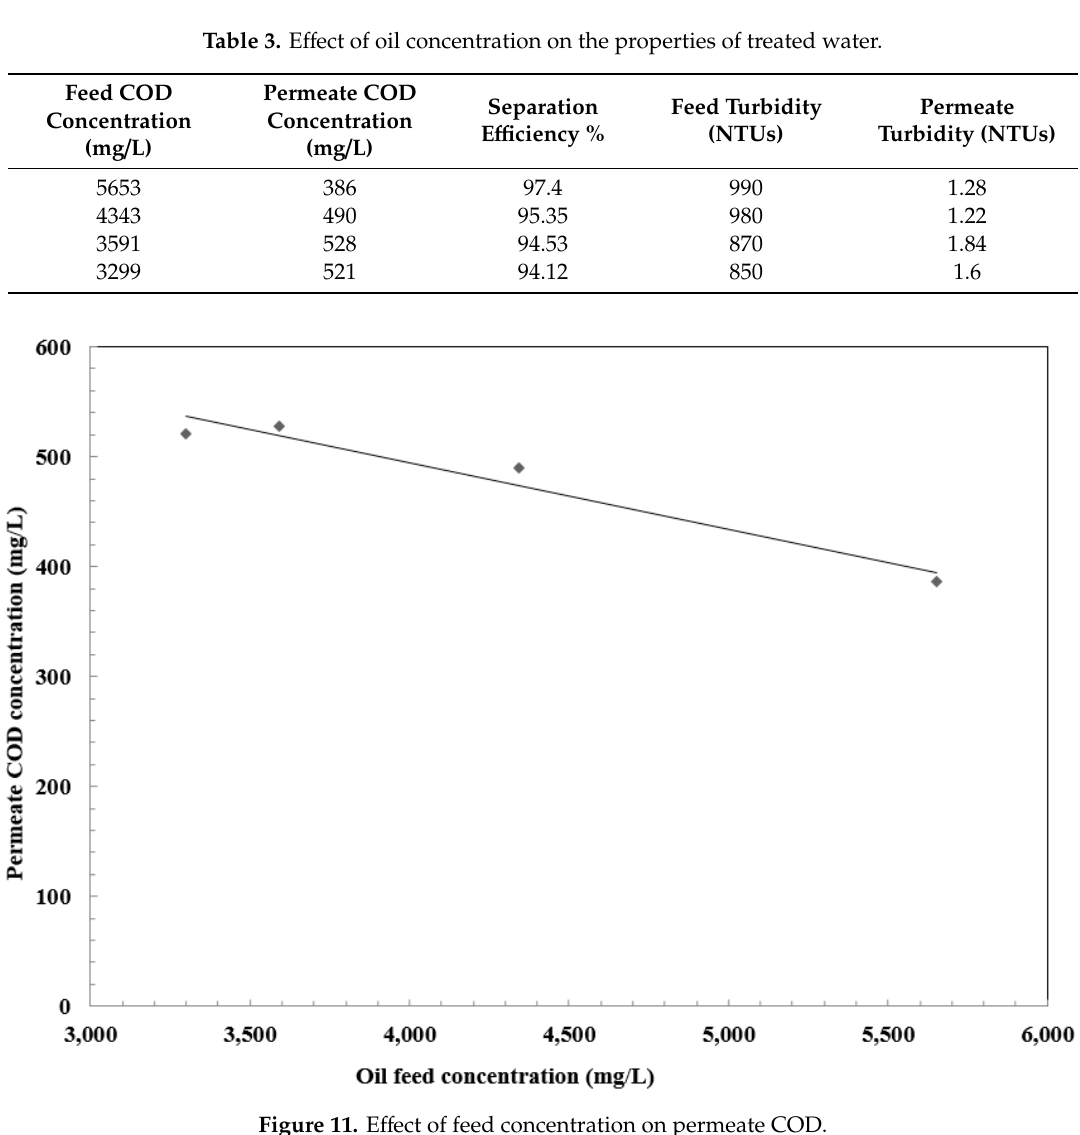
Figure 12. Effect of feed concentration on removal efficiency. 3.6. Effect of Adsorption Pretreatment unit on Membrane Filtration Performance Permeate flux decreased as a result of membrane fouling and concentration polarization. Using activated carbon pretreatment unit led to a decrease in suspended solids’ load on membrane filtration. Oil removal improved to 99.9% in the presence of a pre-treatment unit as listed in Table 2. Oil concentration in terms of COD in the permeate stream was less than 100 mg/L which meets the national discharge standards of wastewater.